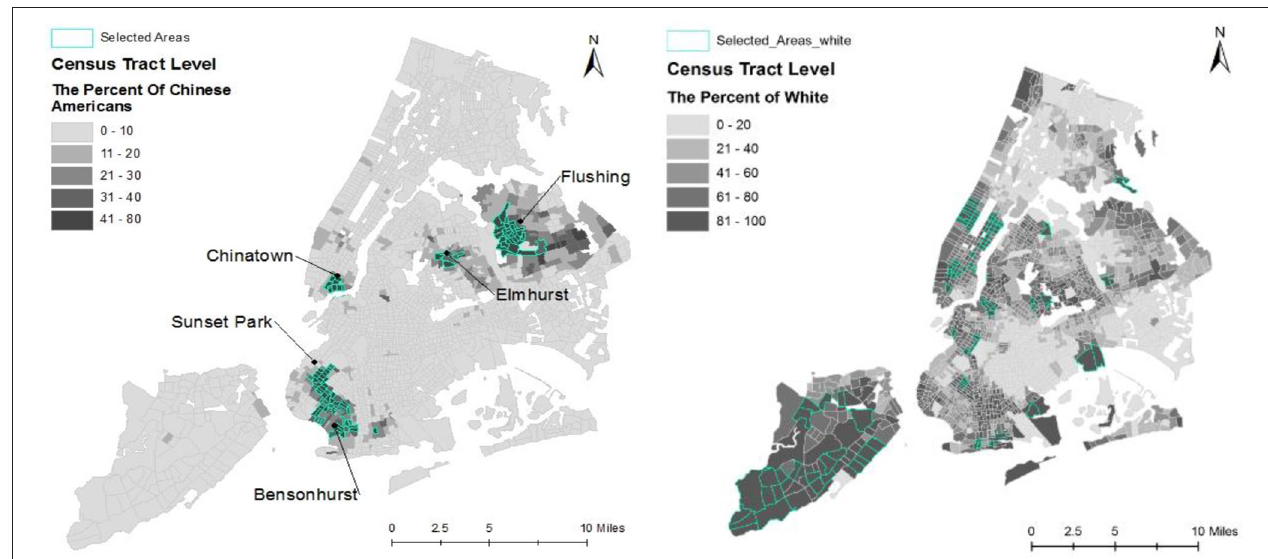
FIGURE 6 | Maps of Chinese American ethnic enclaves (left panel) and non-ethnic enclave areas (right panel), New York City.